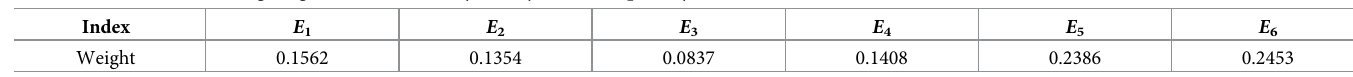
Table 14. Normalized ranking weight vector of final layer of dynamic competency.